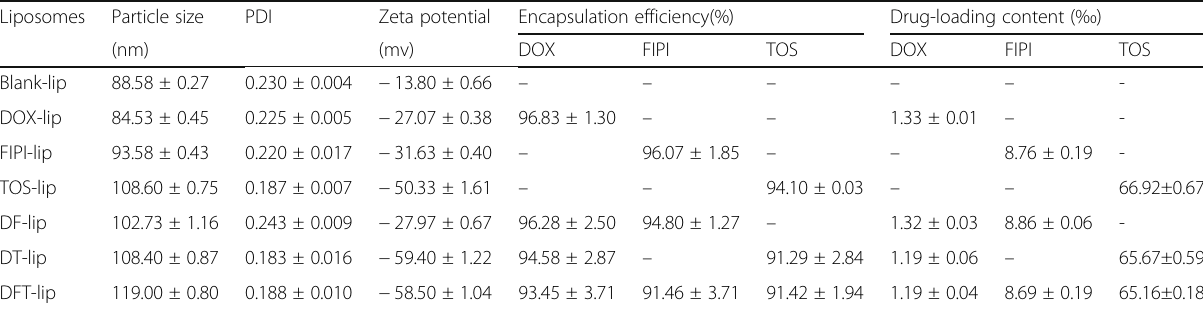
Table 1 Characterization of all liposomes Liposomes